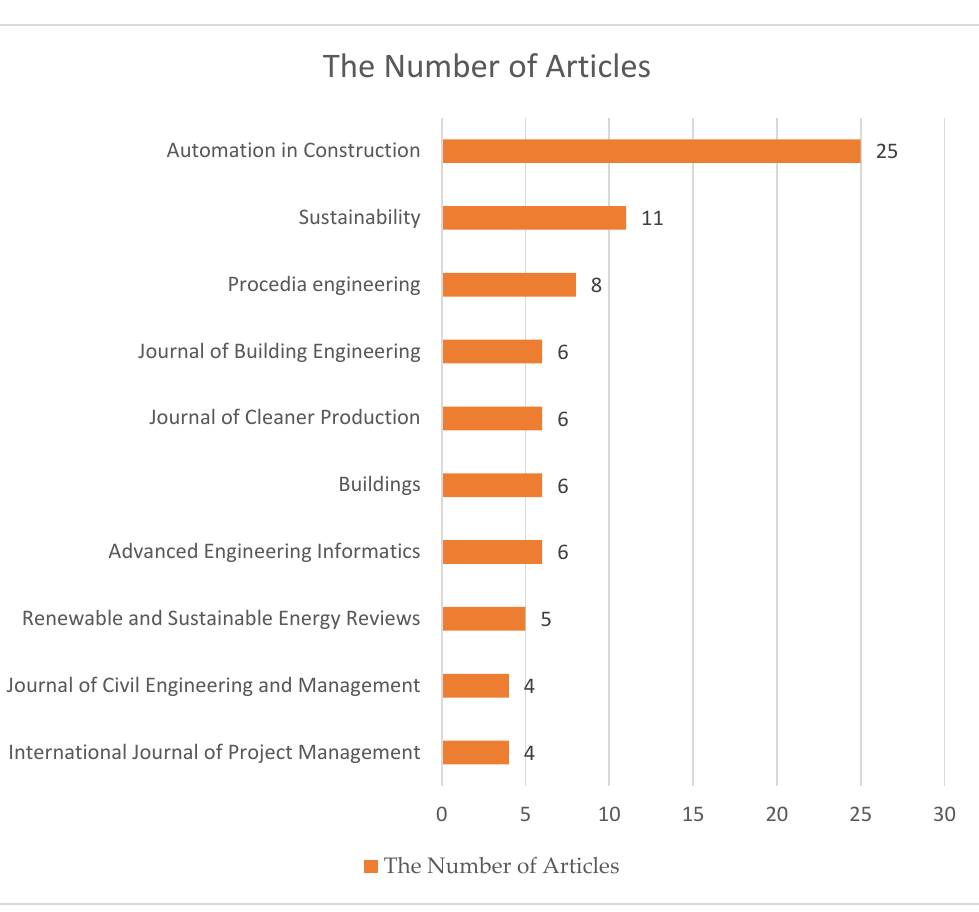
Figure 3. Number of reviewed articles published per journal.